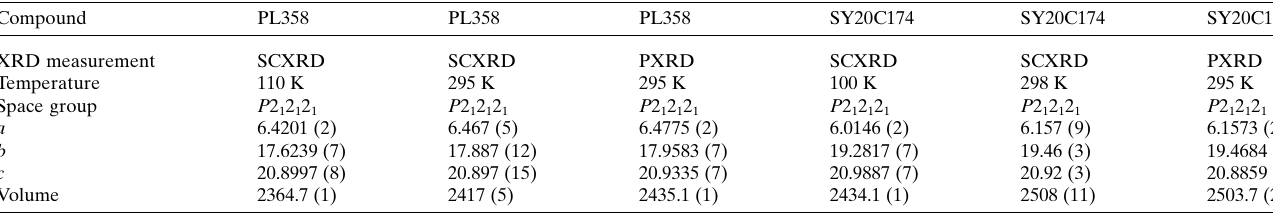
Table 4 Cell parameters determined from SCXRD and PXRD at different temperatures. Compound